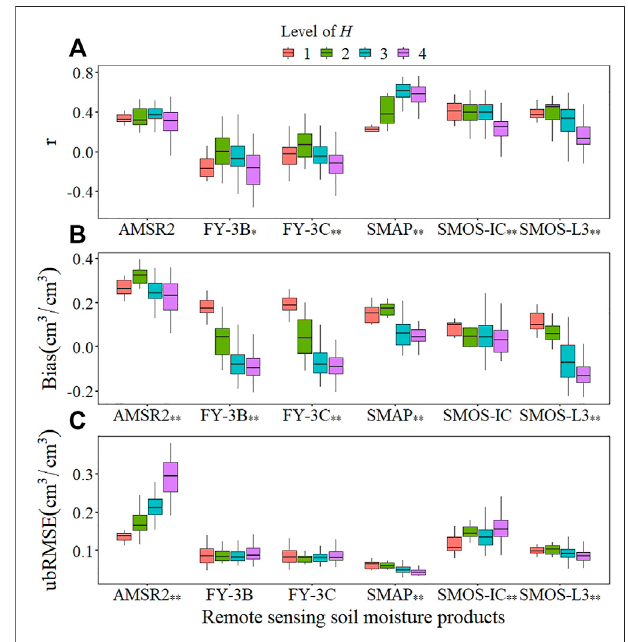
FIGURE 4 | Box diagrams of topographic factors and error coef fi cients of each product. * indicates the signi fi cance t -test ’ s p < .05 and indicates p < .01.